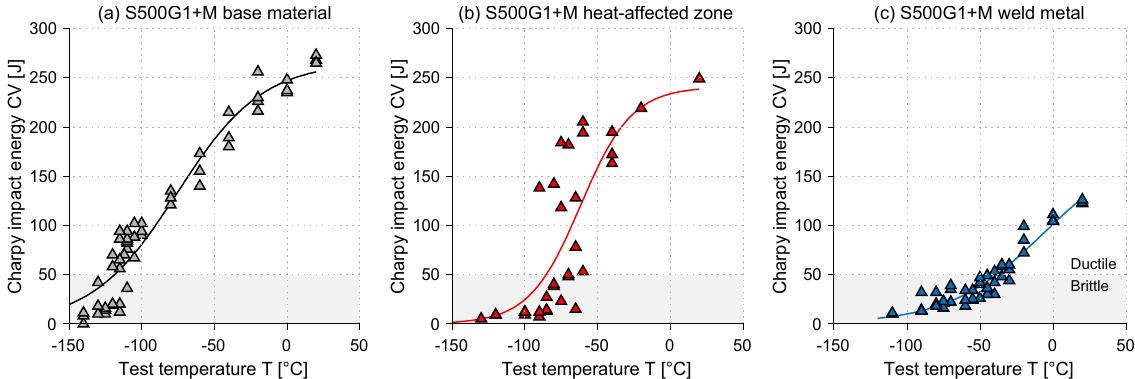
Figure 10. Charpy V-notch impact toughness results for ( a ) base material, ( b ) heat-affected zone, and ( c ) weld metal of S500G1+M steel, based on [32,42]. Different curve trends are observed for the different zones of the welded joint. First of all, the base material has DBTT ( T 50 J = − 119 ◦ C) much lower than the minimum requirement of 50 J according to DNVGL-OS-B101 [43]. Furthermore, the heat-affected zone shows a very low DBTT of T 50 J = − 85 ◦ C. In contrast, a much lower toughness and higher transition temperature is observed ( T 50 J = − 39 ◦ C) for the weld